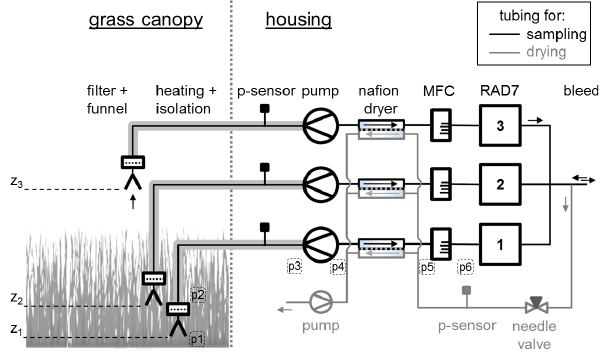
Fig. 1. Simplified gas flow scheme of the automated Tn and Rn profile system. The positions of the pressure measurements (p1–p6) mentioned in Sect. 2.4.1 are